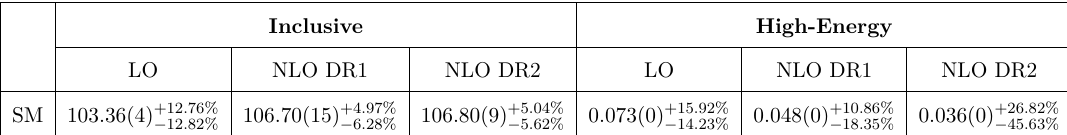
√ s = 13 TeV and c i = 1 TeV − 2 . Λ 2